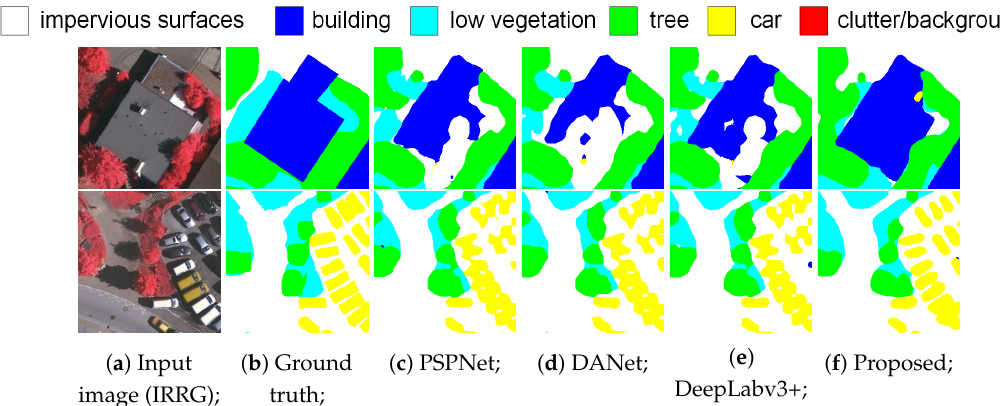
Figure 9. Examples of semantic segmentation results on the Vaihingen dataset. Major differences are highlighted (zoom in to see more